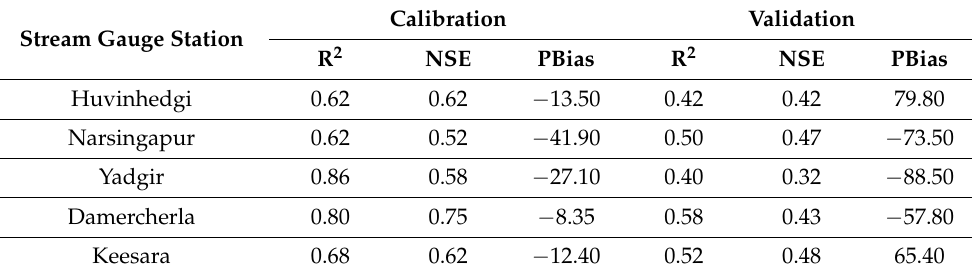
Table 4. Goodness of fit parameters for calibration and validation